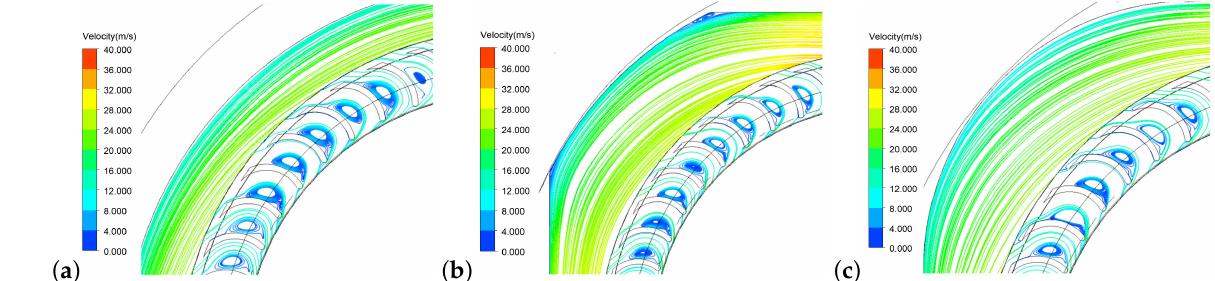
Figure 10. Velocity contour in section A for different volutes: ( a ) LVP, ( b ) CVP, ( c ) RRVP.